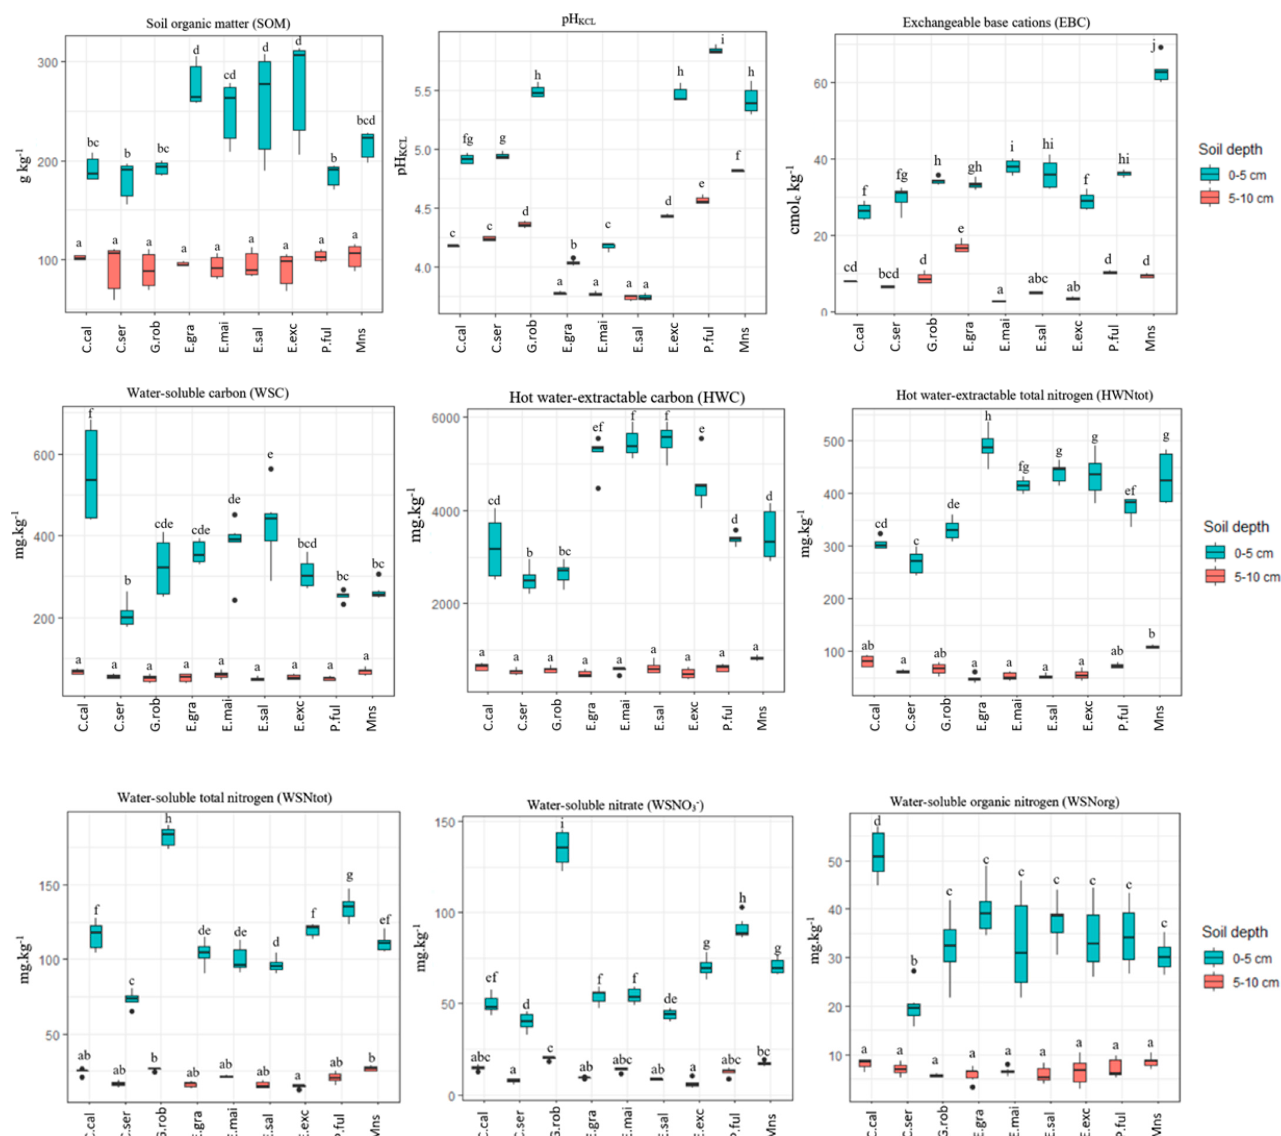
Figure 3. Predicted (LMM) soil properties under eight tree species (C. cal: Calliandra calothyrsus; C. ser: Cedrela serrata; G. rob: Grevillea robusta; E. gra: Eucalyptus grandis; E. mai: Eucalyptus maideni; E. sal: Eucalyptus saligna; E. exc: Entandrophragma excelsum; P. ful: Polyscias fulva ) and in the plot with mixed native species (Mns) at two soil depths (0–5 cm and 5–10 cm). The horizontal black line in the box shows the estimated sample median, while the lower and the upper box boundaries show the first and the third percentiles, respectively. The dots outside the whisker boundaries show observations outside the 5th–95th percentile range. Different letters denote significant differences between tree species and soil layer (mixed linear models, Tukey’s HSD, p < 0.05).